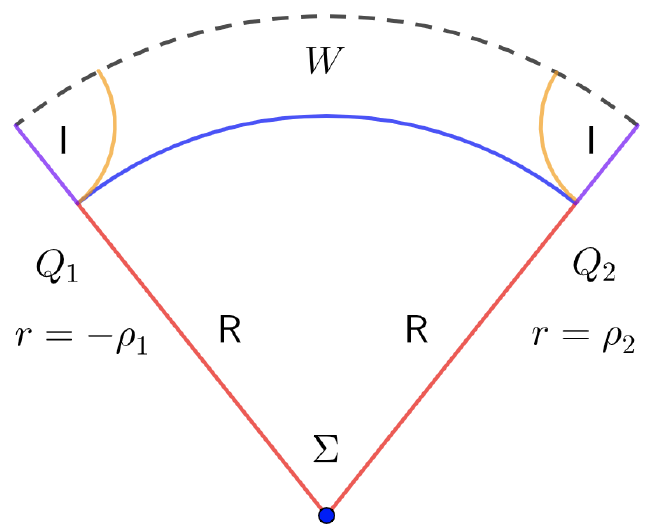
Figure 13 . Geometry for case II: two black holes. The red and purple lines denote the radiation R and island I on branes. The dotted line, blue, and orange lines indicate the horizon, RT surface in the island phase, and RT surface in the no-island phase at t = 0 , respectively.